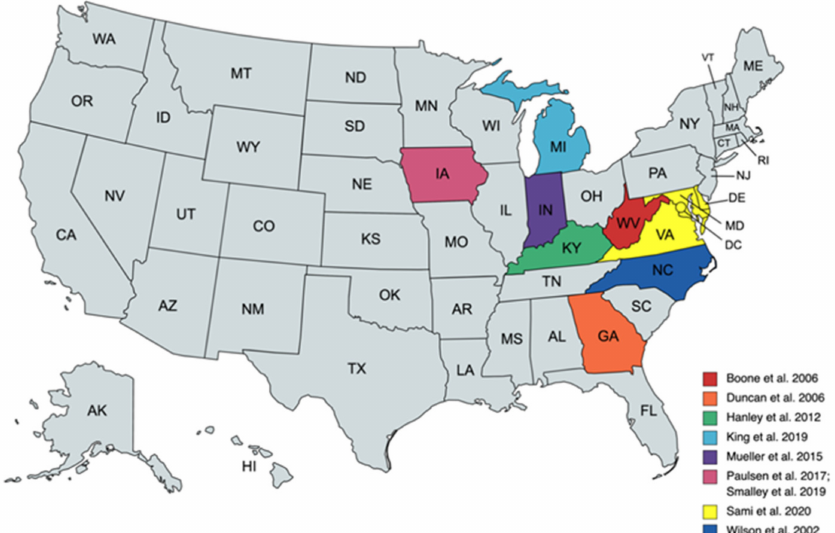
Figure 4. Distribution of study participants throughout the USA (n = 10). Additionally, Weeks, Lawver, Sorensen and Warnick [23] recruited participants across the nation (not shown). Map adapted from https://www.mapchart.net (accessed on 1 April 2022) licensed under Creative Commons